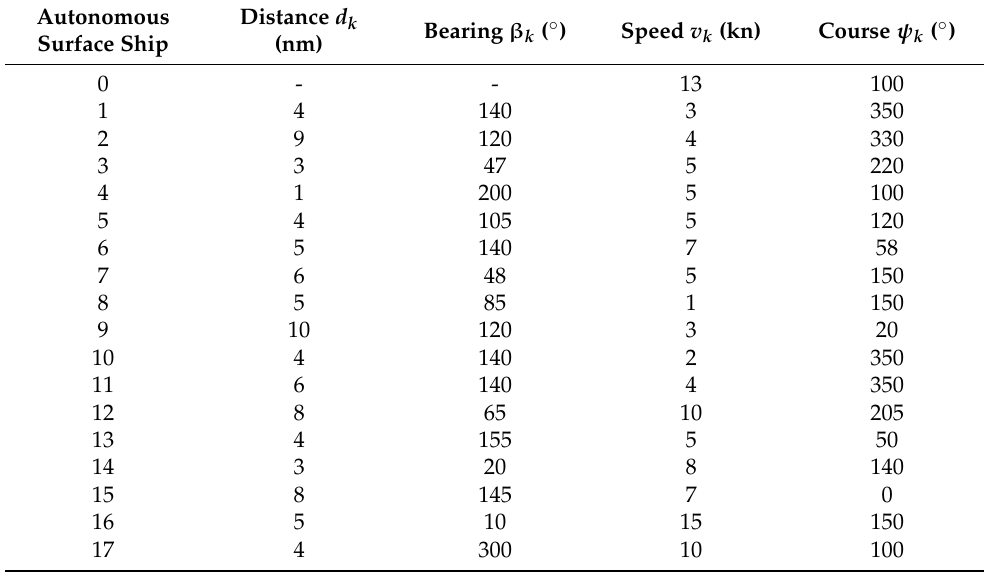
Table 2. Kinematic data of the autonomous surface vessel 0 and the encountered ( K = 17) autonomous surface ships .